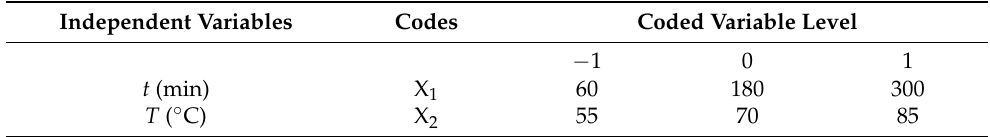
Table 1. Codification and actual values of the independent variables used to set up the experimental